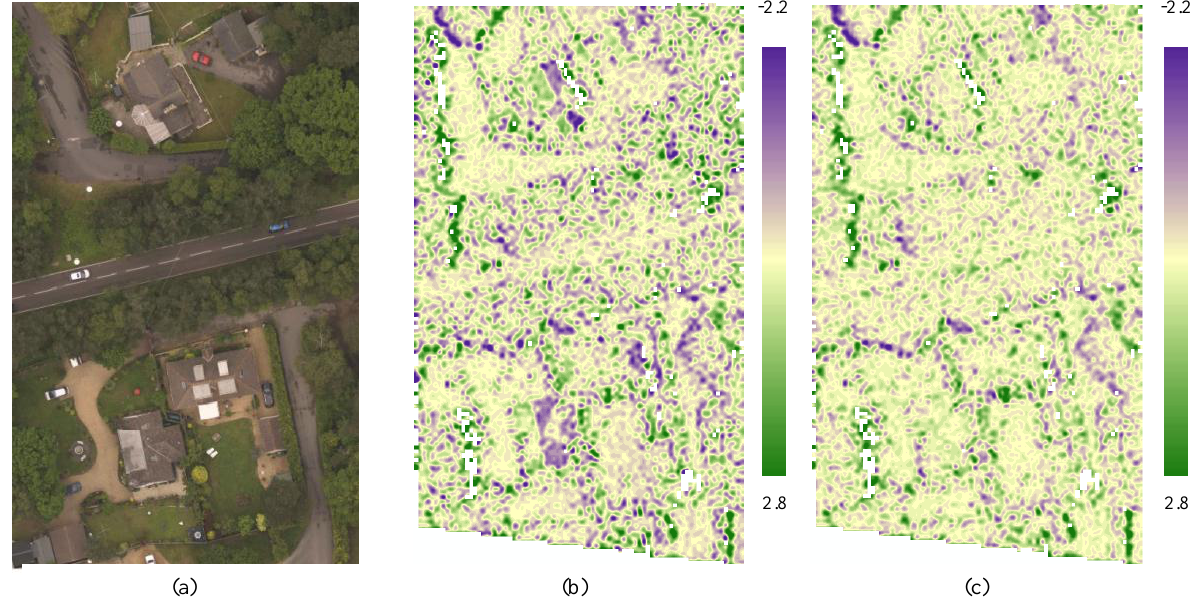
Figure 5. Difference maps from two overlapping flightlines of an interest area in the Bournemouth study site: (a) orthophoto of the interest area; (b) original echo amplitude difference map; (c) ˠ θ difference map.